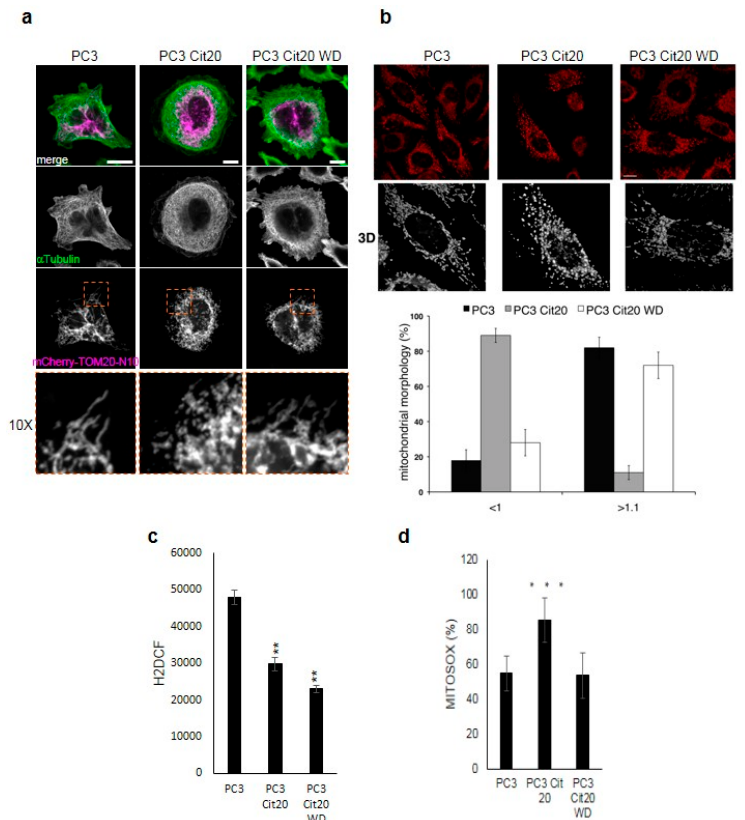
Figure 3. The mitochondrial network is altered in citrate-resistant PC3 cells. Representative images of PC3, PC3 Cit20, and PC3 Cit20 WD cells labeled with mCherry-TOM20-N10 ( a ) or with MitoTracker Red ( b ) are shown. In (a), cells were also stained using a mouse monoclonal antibody against α tubulin. In (b), a single Z-section and 3D reconstruction of a higher magnification region is shown. Quantification of mitochondrial shape according to length (in μ m) is shown. Bars, mean ± S.D. Scale bar 10 µ m. ( c ) Effects of citrate on ROS production in PC3, PC3 Cit20, and PC3 Cit20 WD cells. ROS levels were estimated indirectly by